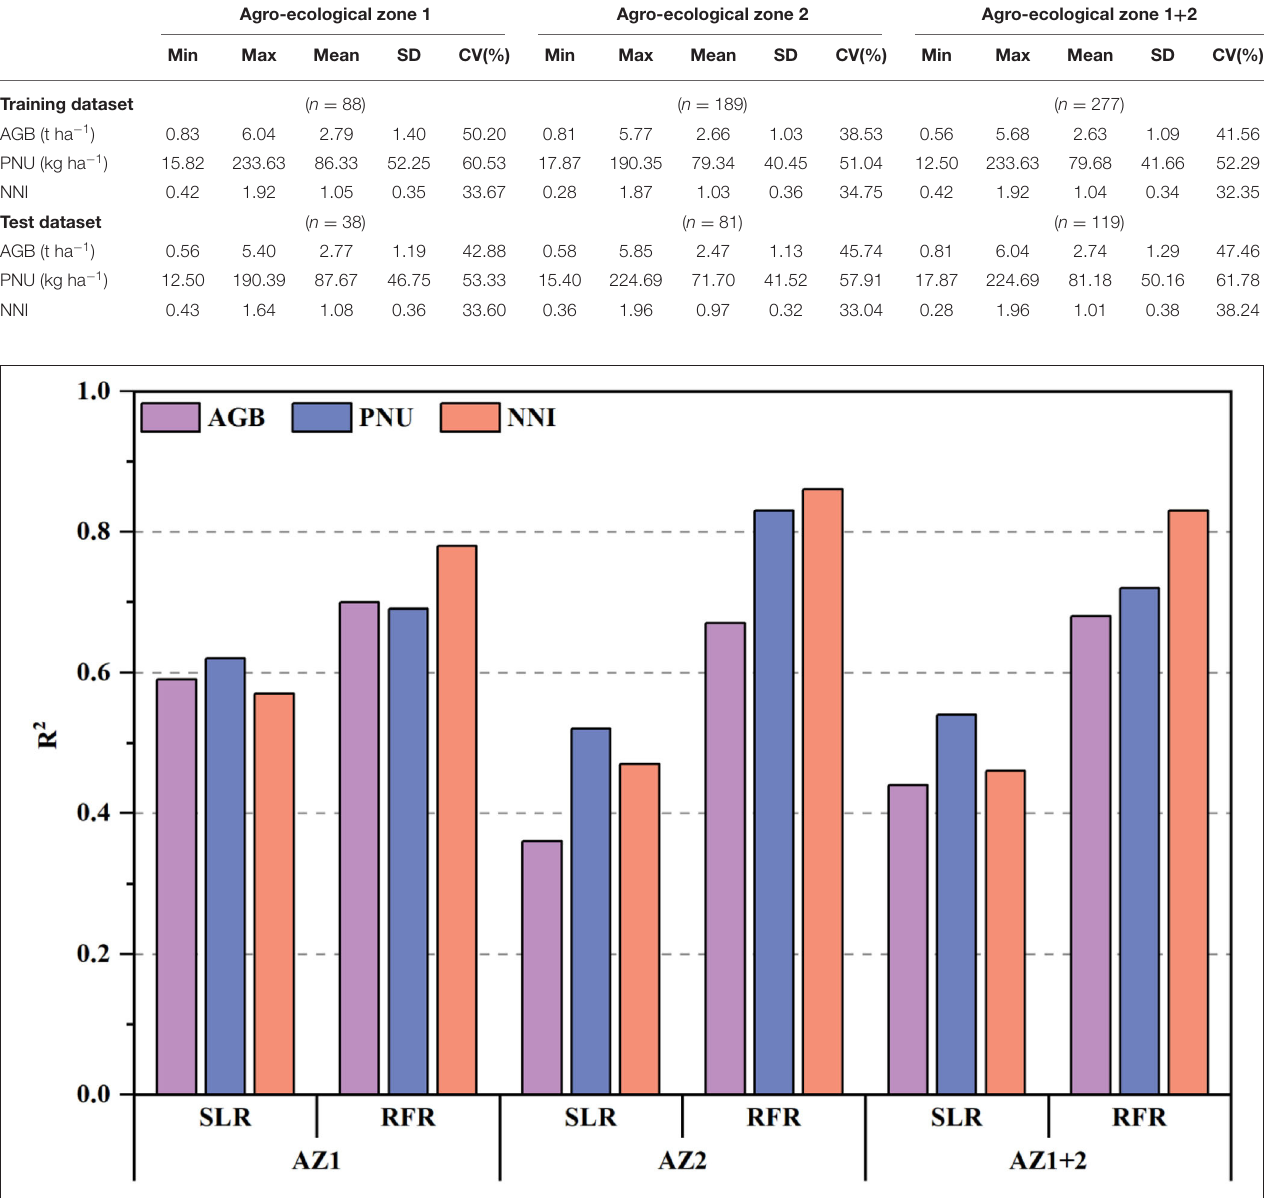
FIGURE 3 | Coefficient of determination (R 2 ) of simple linear regression (SLR) and random forest regression (RFR) for estimating aboveground biomass (AGB), plant N uptake (PNU) and N nutrition index (NNI) in agro-ecological zone 1 (AZ1), agro-ecological zone 2 (AZ2) and across two agro-ecological zones (AZ1 + 2) on the training dataset,